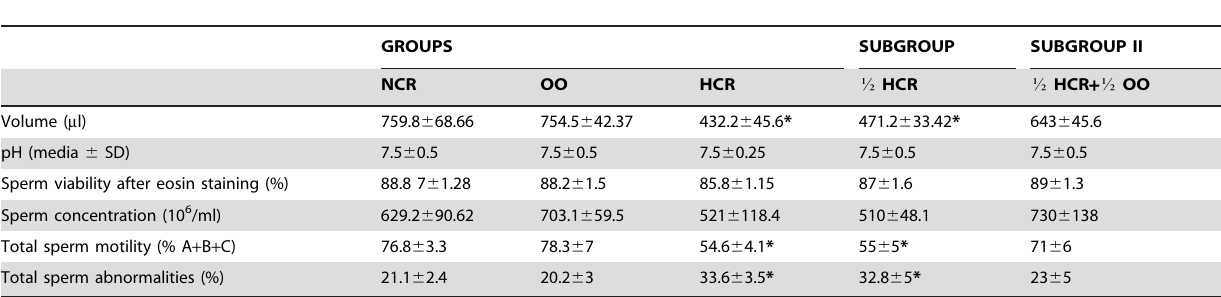
Table 1. General characteristics of fresh rabbit semen samples (mean 6